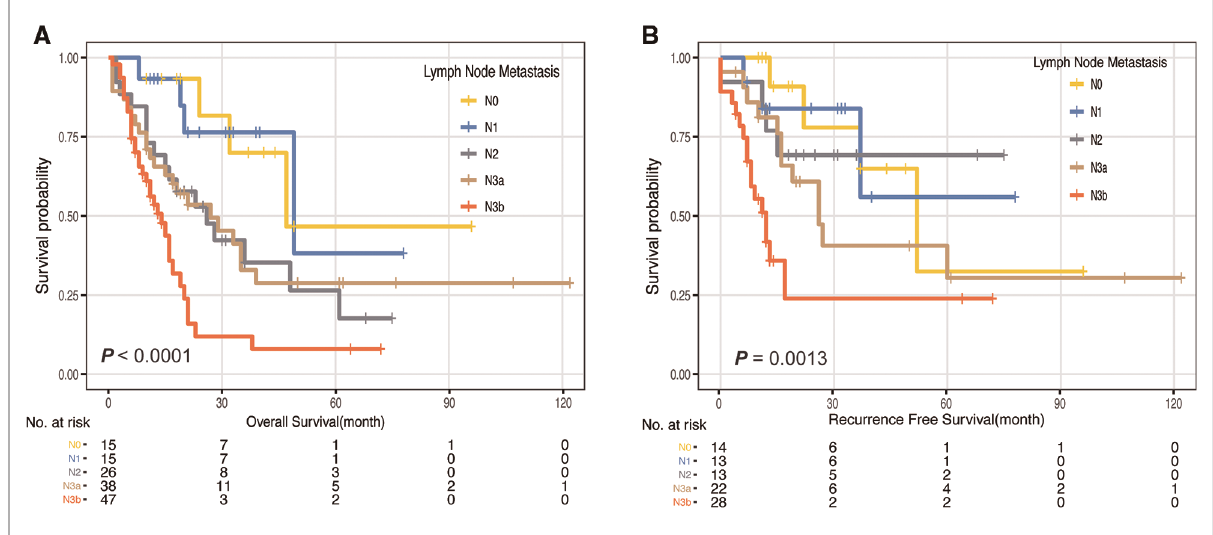
FIGURE 3 Kaplan-Meier curve of pN stage. ( A ) Kaplan-Meier curves of overall survival (OS) according to N category in Borrmann type IV gastric cancer. ( B ) Kaplan-Meier curves of recurrence-free survival (RFS) according to N category in Borrmann type IV gastric